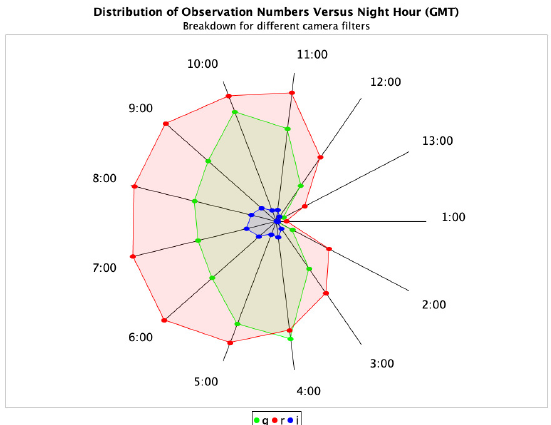
Figure 6. Example spider-web chart made by Thoth. The center of the spider web corresponds to zero (negative values are not allowed for this graph type). Only positive values can be plotted on spider-web charts. Values across categories are compared by perceiving changes in the distance from the center of the spider